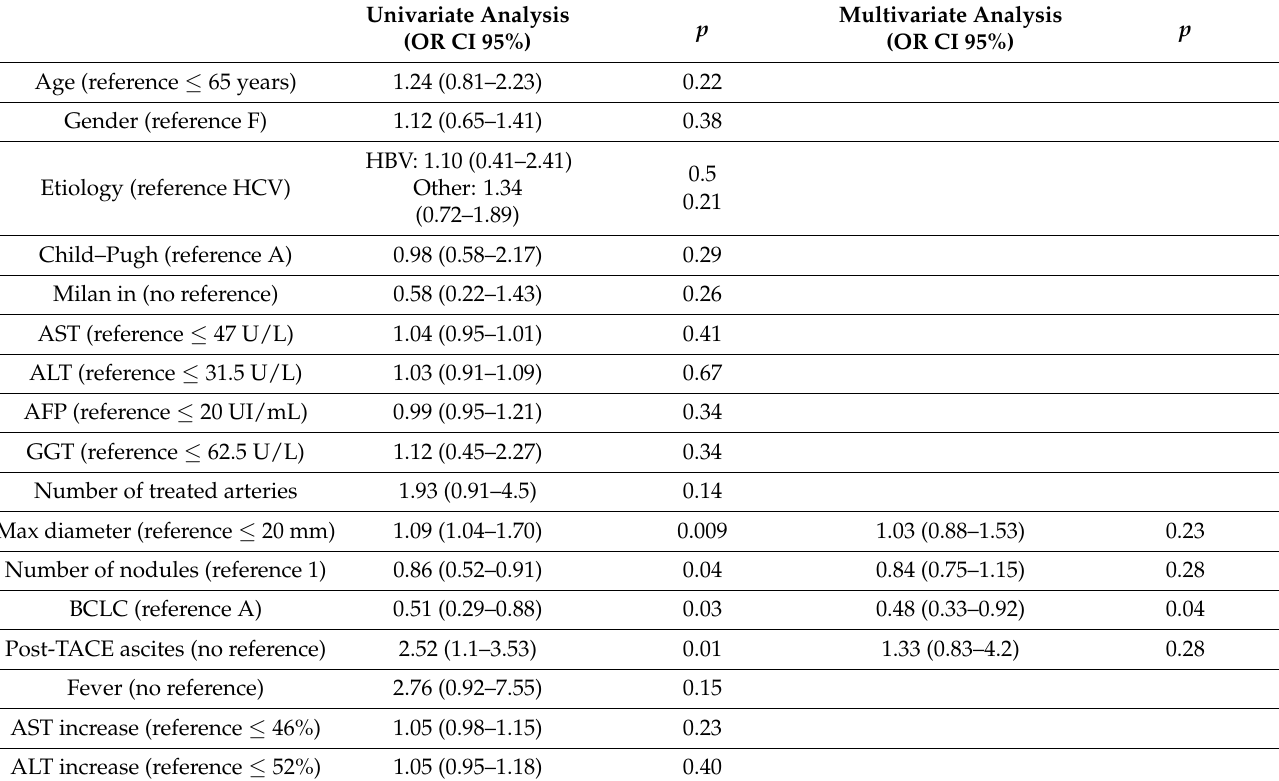
Table 5. Univariate and multivariate logistic regression analyses for the assessment of clinical, laboratory, and procedural data associated with the objective response when considering the overall